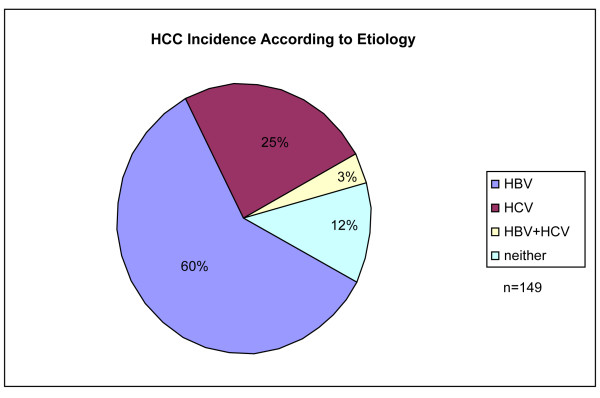
HCC incidence according to underlying etiology (current series). Underlying risk factors for HCC in current series closely resembles global demographic: worldwide epidemiologic data estimate HCC due to HBV in 53-54% of total cases, and due to HCV in 25%-31% of cases